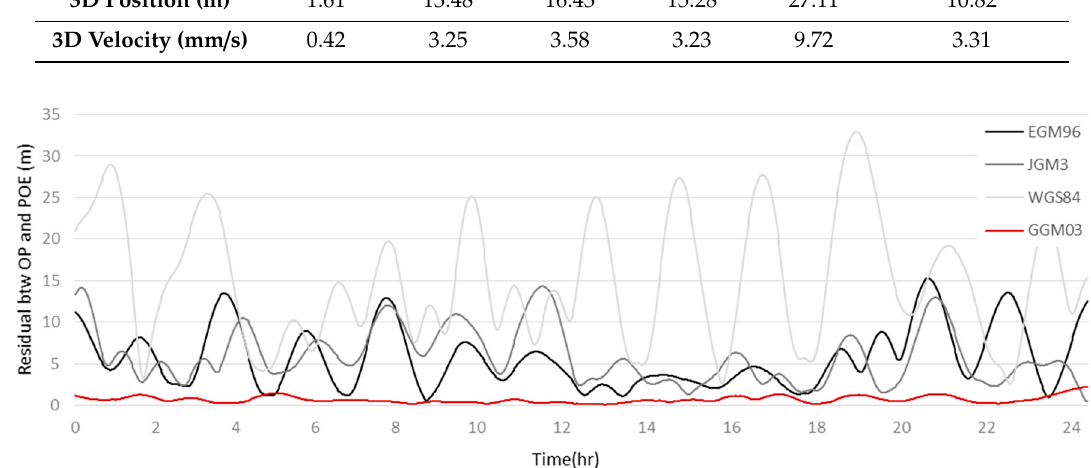
Figure 10. Performance analysis results of various orbit propagation models with respect to the reference orbit, CHAMP POE. Table 4. Performance analysis results of on-board orbit determination with respect to the reference orbit from CHAMP POE.